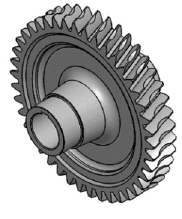
Figure 8. Screw wheel.